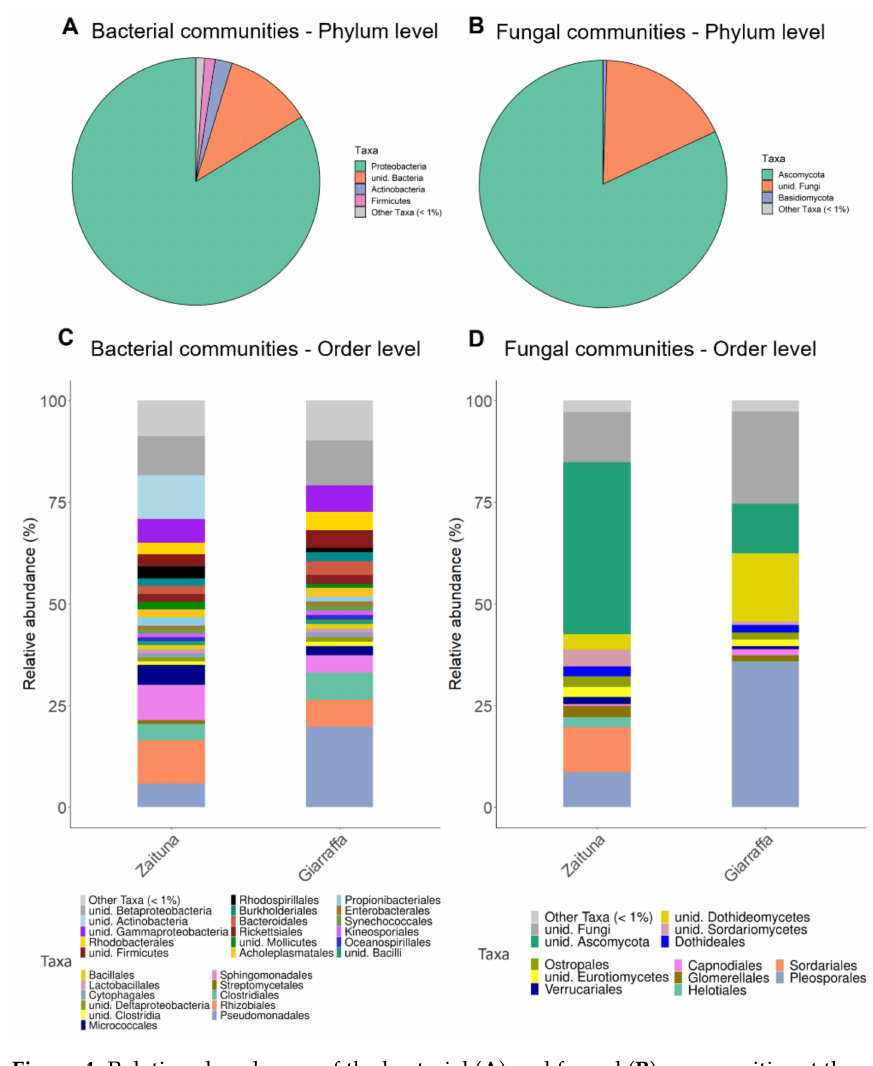
Figure 4. Relative abundances of the bacterial ( A ) and fungal ( B ) communities at the phylum level and the bacterial ( C ) and fungal ( D ) communities at the order level. Bacterial and fungal phyla and orders less abundant than 1% are reported as “Other Taxa”.